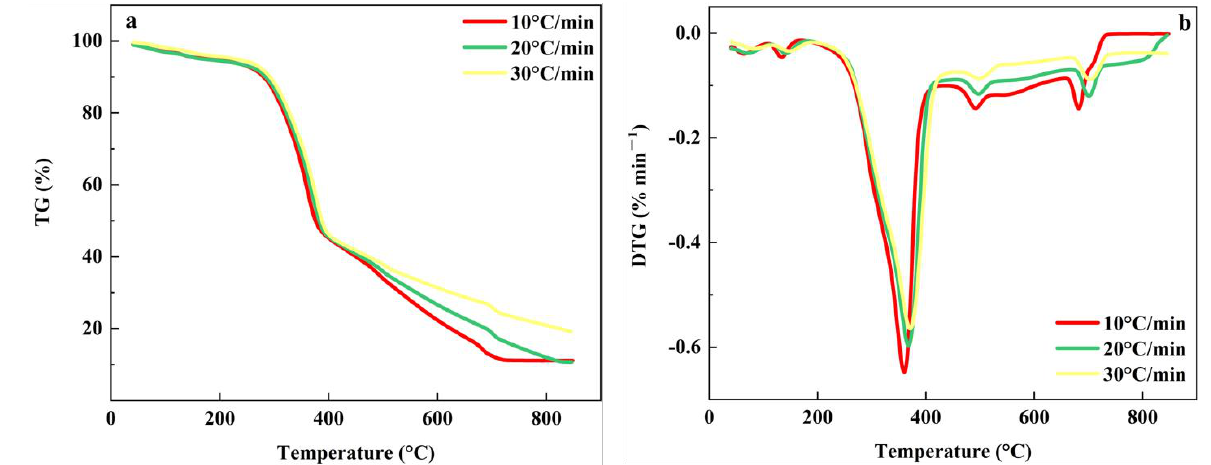
Figure 3. The TG-DTG curve for MS pyrolysis at different heating rates. (a) The TG curve of MS; (b) The DTG curve of MS.